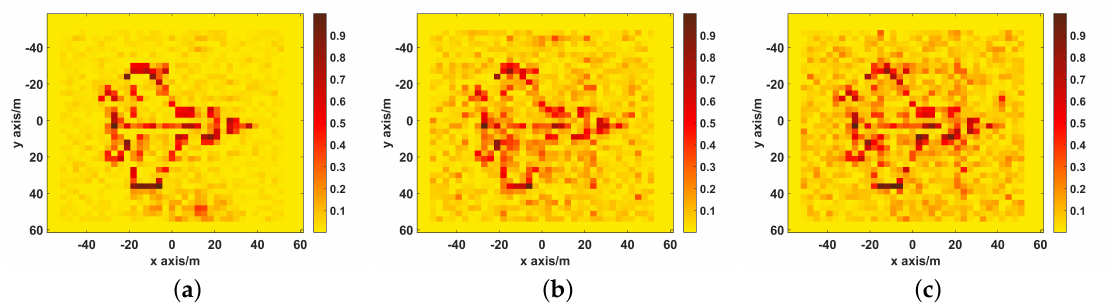
Figure 12. The imaging results of UPIM when only one translation component exists. ( a ) Only translational component along the X t exists, the NMSE is 0.21; ( b ) Only translational component along the Y t exists, the NMSE is 0.58; ( c ) Only translational component along the Z t exists, the NMSE is 0.59.